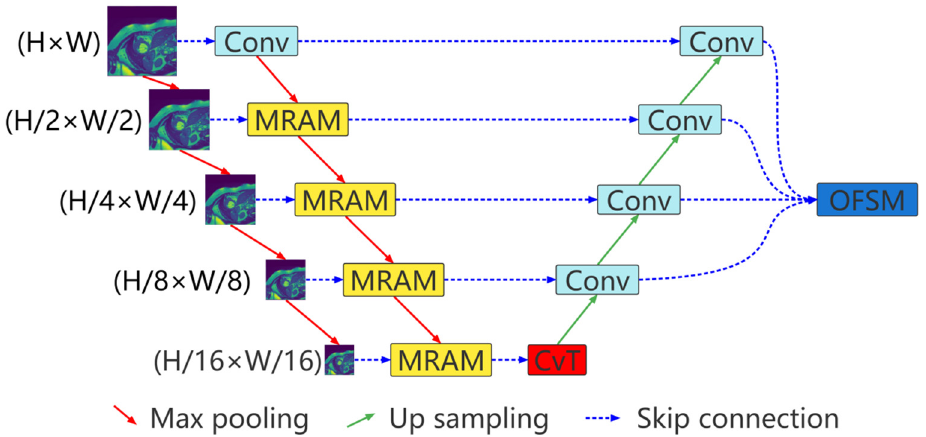
Figure 1. Multiresolution aggregation transformer UNet (MRA-TUNet). Conv: convolution block. MRAM: multiresolution aggregation module. CvT: convolution to vision transformer. OFSM: output feature selection module. H: image height. W: image width.